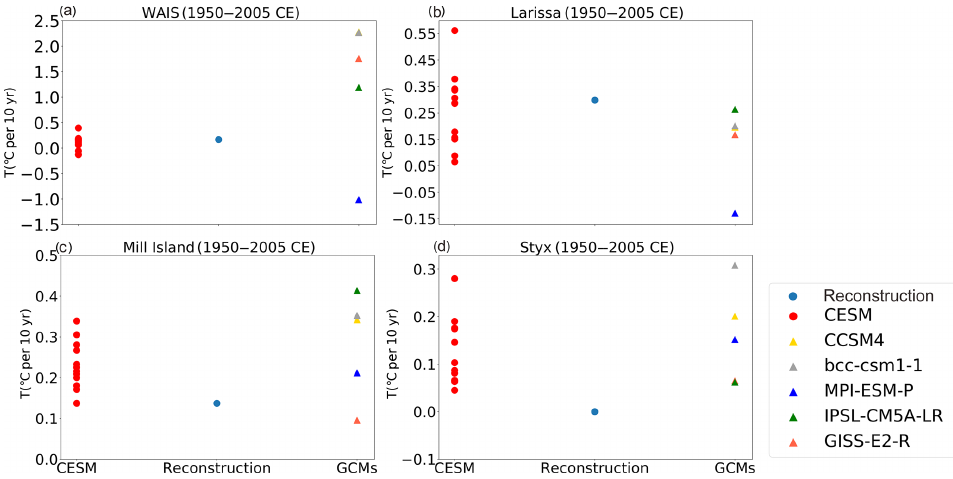
Figure 11. Linear trends for the four boreholes over 1950 to 2005CE: (a) WAIS; (b) Larissa; (c) Mill Island; and (d)